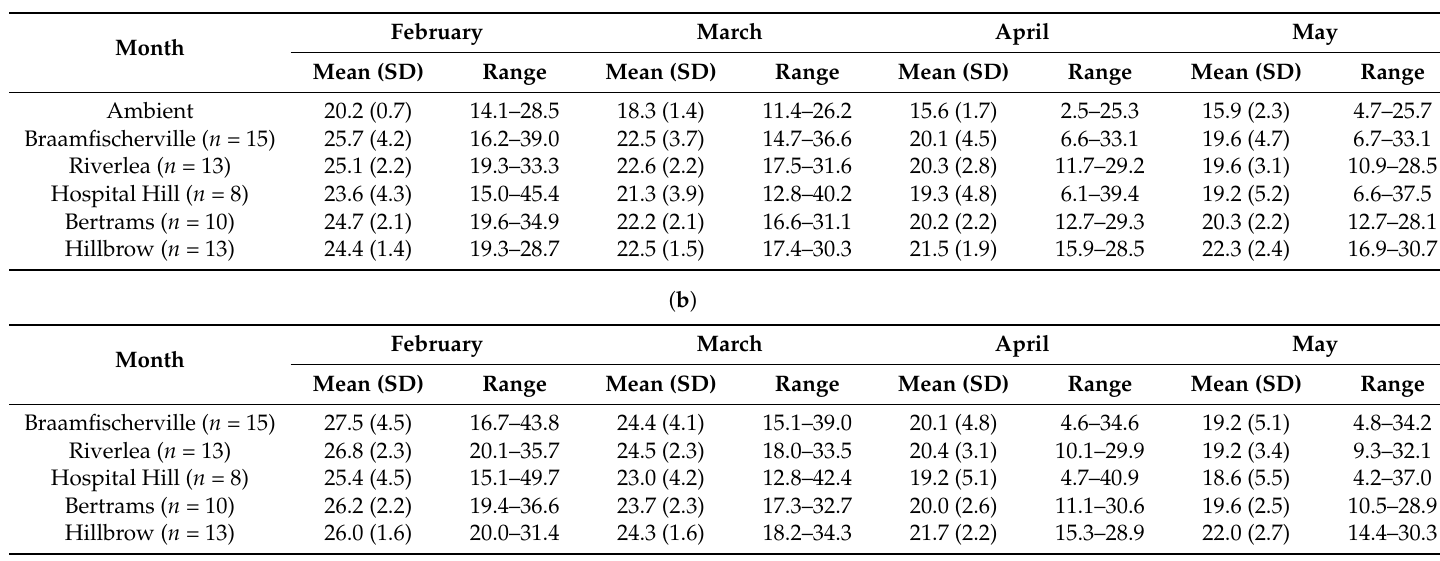
Table 3. ( a ) Mean (standard deviation) and range in monthly indoor and ambient temperatures ( ◦ C); ( b ) Mean (standard deviation) and range in monthly apparent temperatures ( ◦